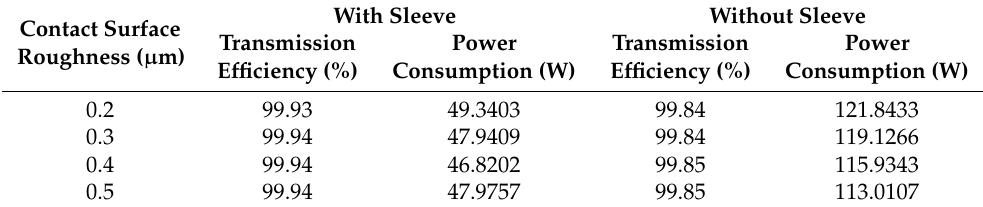
Table 4. Transmission characteristics depending on roughness.